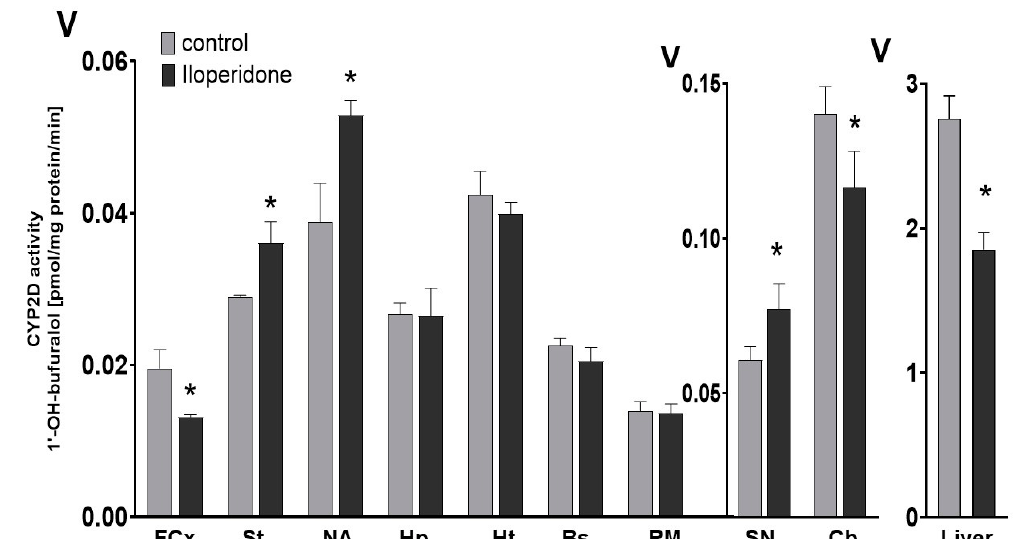
Figure 2. The influence of the two-week treatment with iloperidone on the CYP2D activity measured in microsomes derived from the selected brain structures or liver. The presented values are the means ± S.E.M. of 12 samples (from 12 animals) for the cerebellum, remainder of brain and the liver, of 6 samples (each sample contained 2 pooled brain structures from 2 animals) for the frontal cortex, brain stem, striatum and hippocampus, and of 4 samples (each sample contained 3 pooled brain structures from 3 animals) for the hypothalamus, nucleus accumbens and substantia nigra. Student’s t -test: * p < 0.05 vs. control group. FCx—the frontal cortex, St—the striatum, NA—the nucleus accumbens, Hp—the hippocampus, Ht—the hypothalamus, Bs—the brain stem, SN—the substantia nigra, Cb—the cerebellum and RM—the remainder. Table 1. The CYP2D activity, protein and mRNA levels in the selected brain structures and liver. Tissue